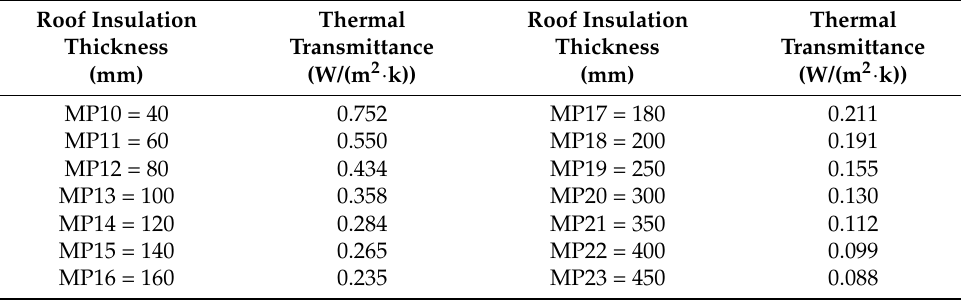
Table 3. Modification parameter design plan (MP)—Roof insulation